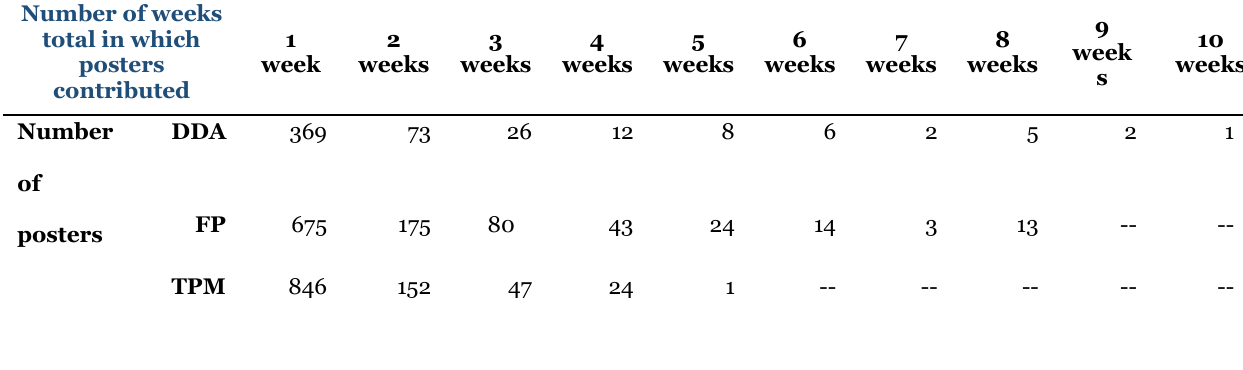
Total Weeks of Contribution Per Poster Number of weeks total in